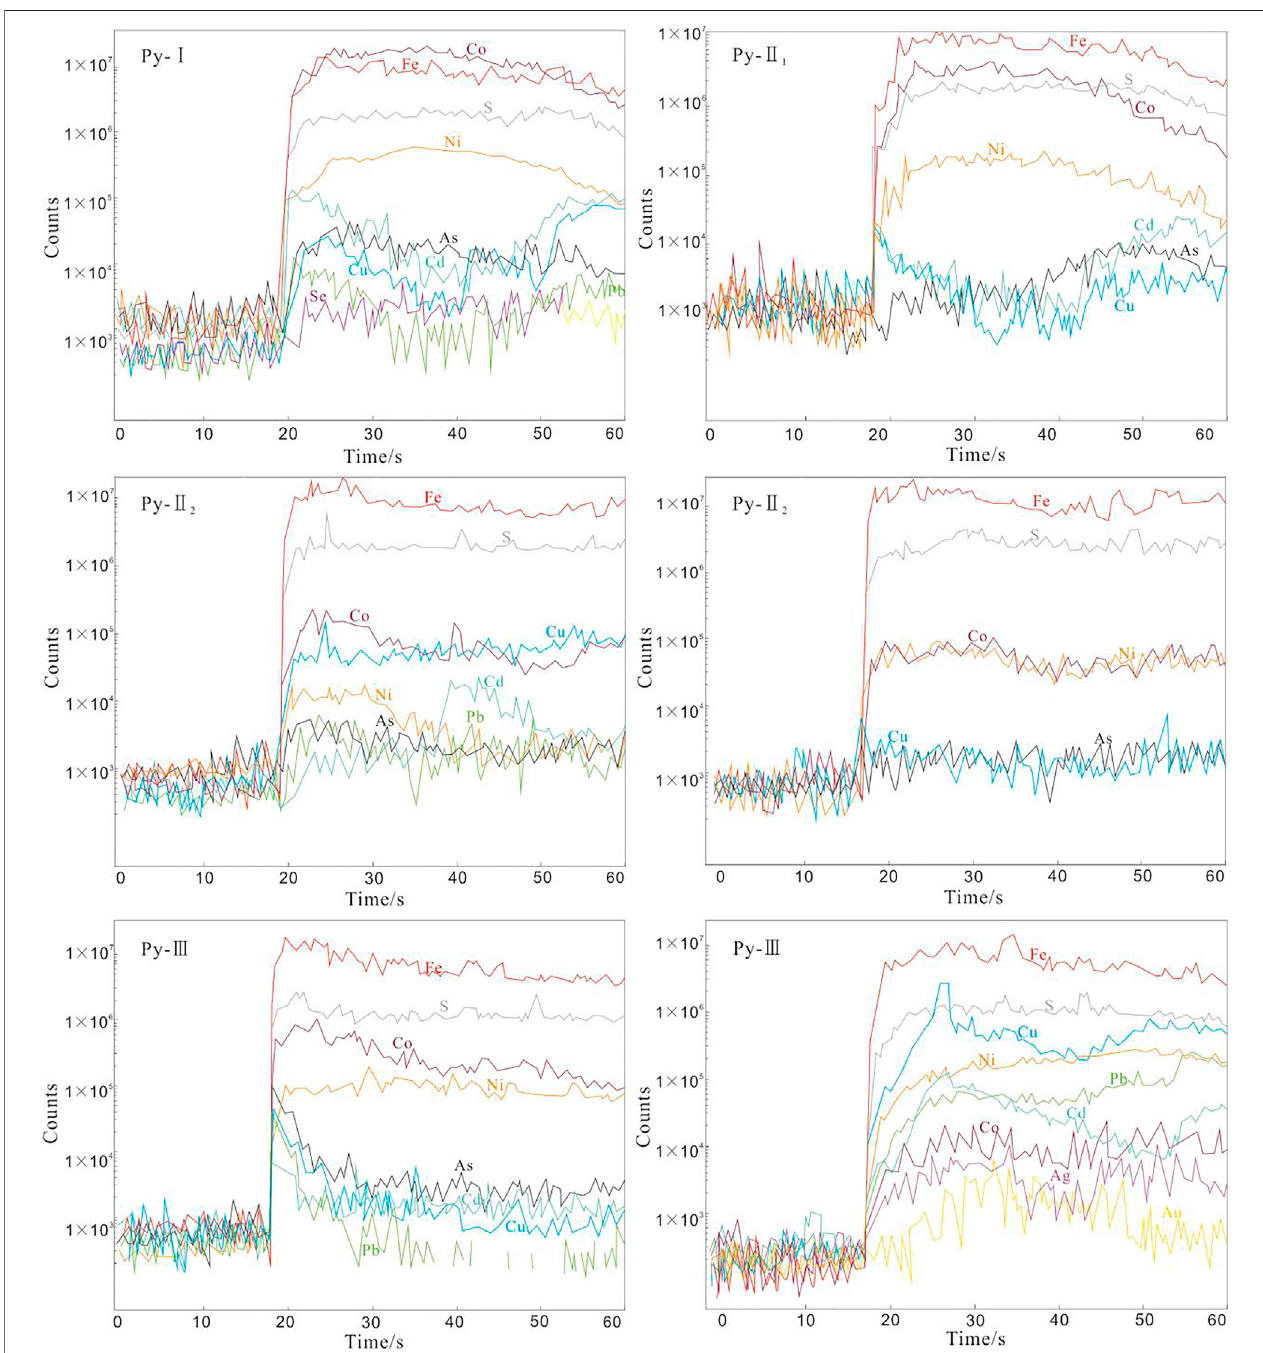
FIGURE 8 | LA-ICP-MS ablation curves of pyrite in different mineralization stages of the Tuwu porphyry Cu deposit in eastern Tianshan, Xinjiang, NW China.